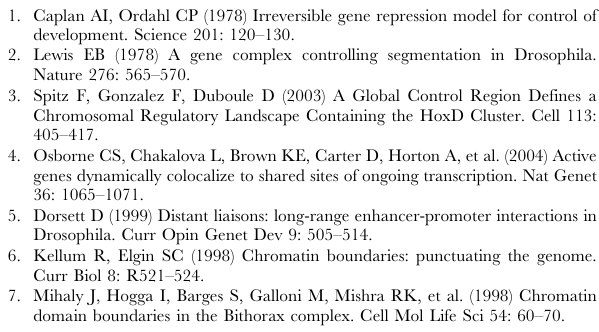
Figure S1 Crosses to generate Abd-B D PTE-UP mutant. ( A ) Schematic diagram of the Abd-B LDN P element insertion